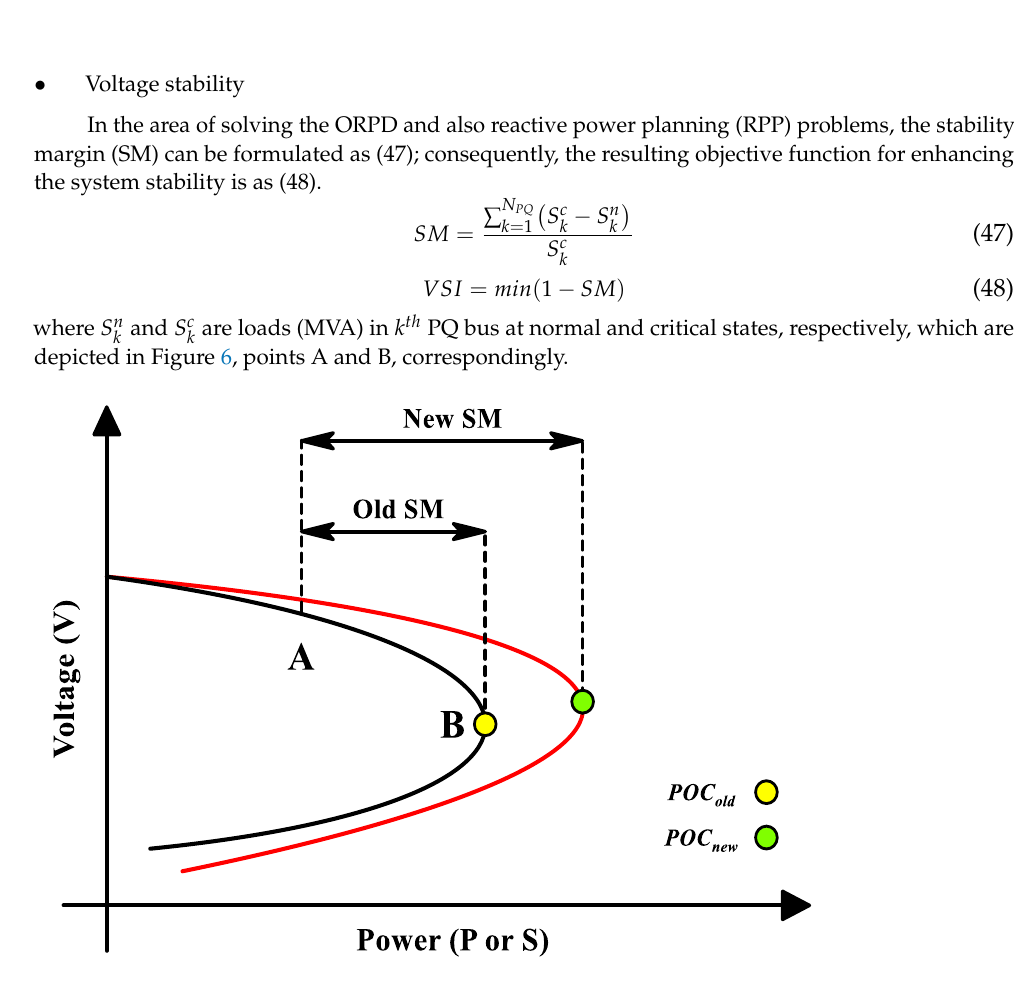
Figure 6. The plot of voltage stability characteristics.